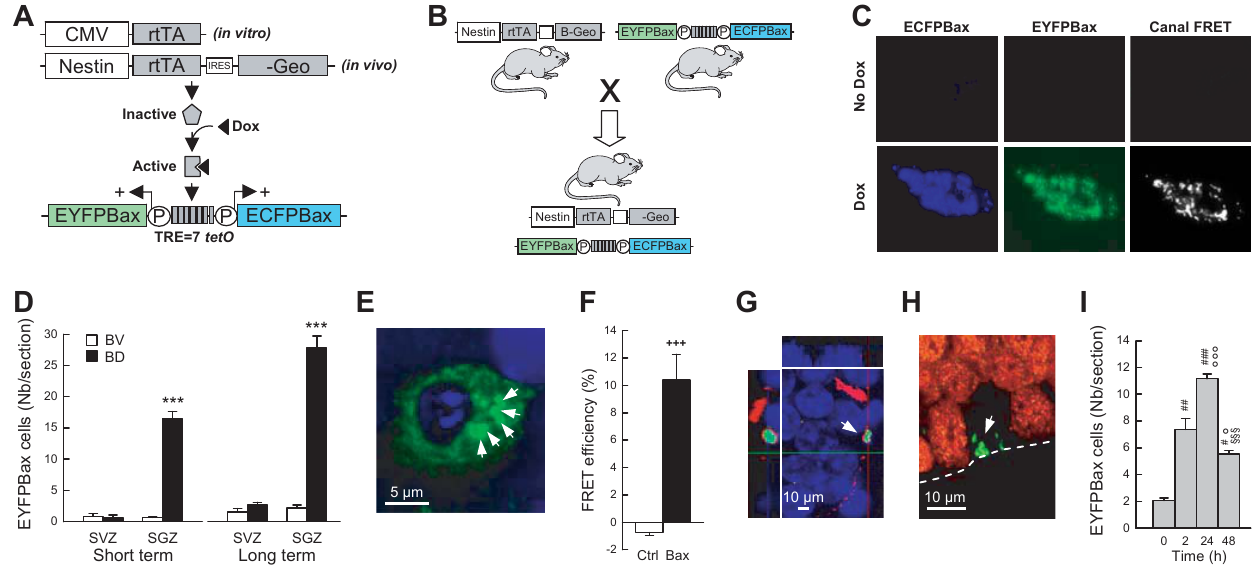
Figure 1. Inducible expression of Bax proteins in hippocampal neural precursors using a Tet-On system. ( A ) Schematic representation of the inducible Tet-ON system. rtTA expression is driven either in vitro by the CMV promoter in stably transfected CHO-K1 Tet-ON cells or in vivo by the rat nestin intron II enhancer/promoter. Doxycycline (Dox) activates the rtTA protein, which binds to seven TetO sequences (TRE) to drive the co- transcription of ECFPBax and EYFPBax transgenes. ( B ) Strategy to obtain Dox-dependent ablation of neural precursors in vivo using double transgenic nestin-rtTA/Tet-Bax mice. ( C ) Six hours of Dox treatment induces ECFPBax and EYFPBax expression and multimerization in CHO-K1 Tet-ON cells. The presence of ECFPBax/EYFPBax multimers at the mitochondrial membrane was confirmed by FRET analysis. ( D ) Number of Bax multimers in the subventricular zone (SVZ) and the subgranular zone (SGZ) of bigenic mice treated with (bigenic-Dox mice, BD) or without (bigenic-vehicle mice, BV) Dox (2 mg/ml) during a short term (3 weeks) or a long term (17 weeks) period. ( E ) Confocal illustration showing EYFPBax (green) clusters (arrows) in the cytoplasm of cells located in the SGZ of bigenic-Dox mice (blue=hoescht nuclear counterstaining). ( F ) FRET analysis of Bax multimers shows the intermolecular interaction between ECFPBax and EYFPBax fusion proteins. FRET efficiency measured following EYFPBax acceptor photobleaching results in a brightening of the ECFPBax donor fluorescence in areas devoid of (Ctrl) or containing (Bax) Bax multimers. ( G ) Confocal illustration showing that nestin-IR neuronal precursors (red) are positive for EYFPBax (green). Hoescht nuclear counterstaining is shown in blue. ( H ) Confocal illustration showing that NeuN-IR mature granule neurons (red) are negative for EYFPBax (green). ( I ) Number of Bax multimers in the SGZ of bigenic mice treated acutely with Dox (2 mg/ml/100 g body weight, i.p.) and sacrificed at different time intervals. ***: p # 0.001 compared to BV, +++ : p # 0.001 compared to Ctrl areas, # : p # 0.05, ## : p # 0.01, ### : p # 0.001 compared to 0 h, u : p # 0.05, uuu : p # 0.001 compared to 2 h, 111 : p # 0.001 compared to 24